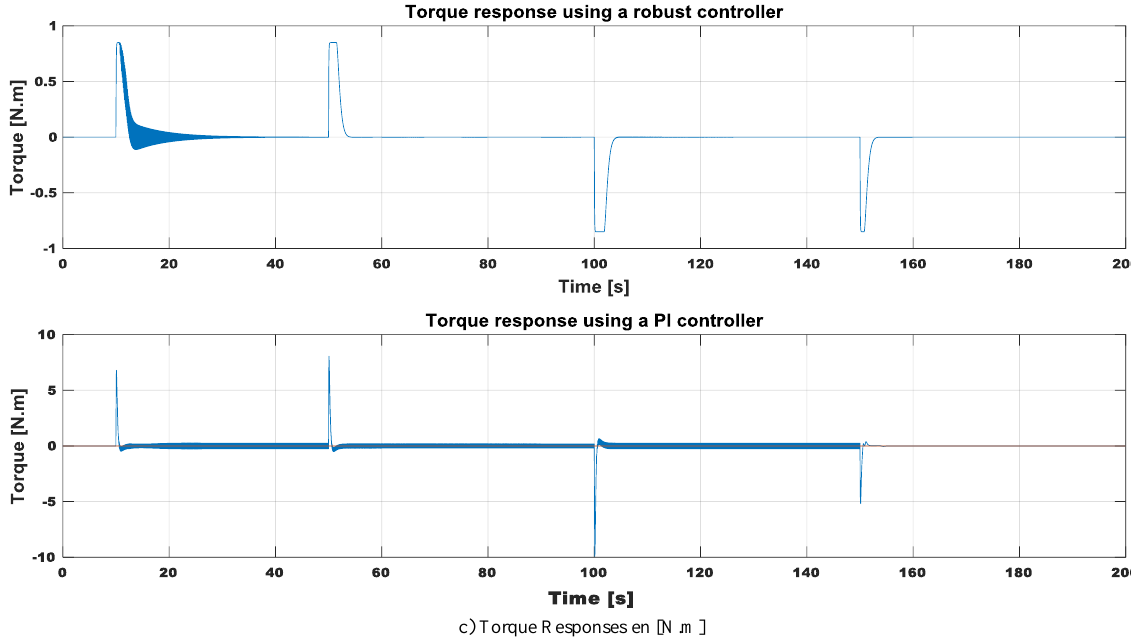
Figure 13. A comparative study of conventional PI and 𝑯 ∞ anti-windup controllers for direct vector control applied to an asynchronous